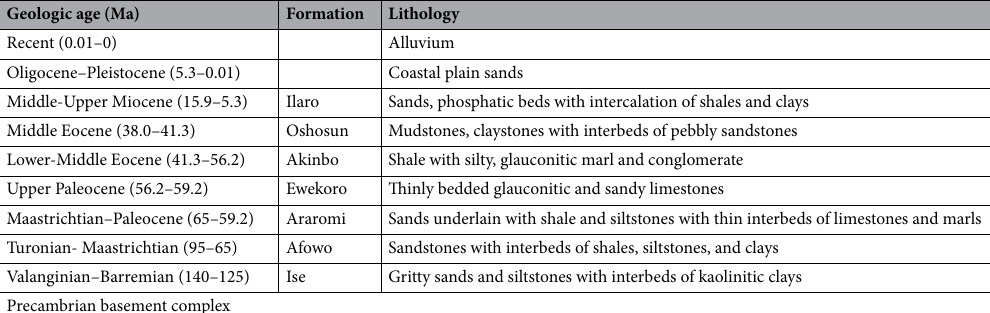
Table 1. Summary of formations within the Eastern Dahomey Basin (Modified from 16 ).